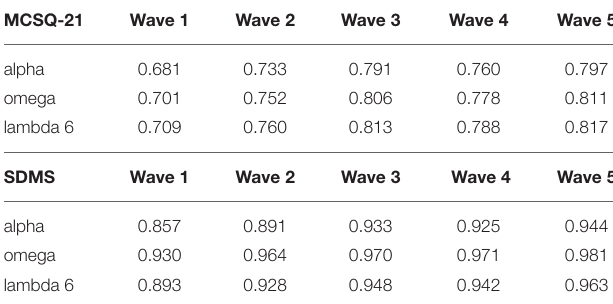
TABLE 1 | Reliability estimates of the MCSQ-21 and the